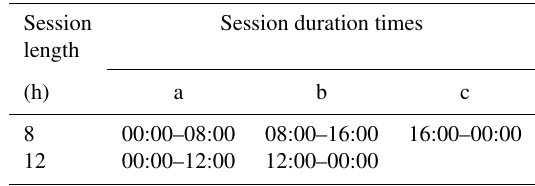
Table 1. Segmented